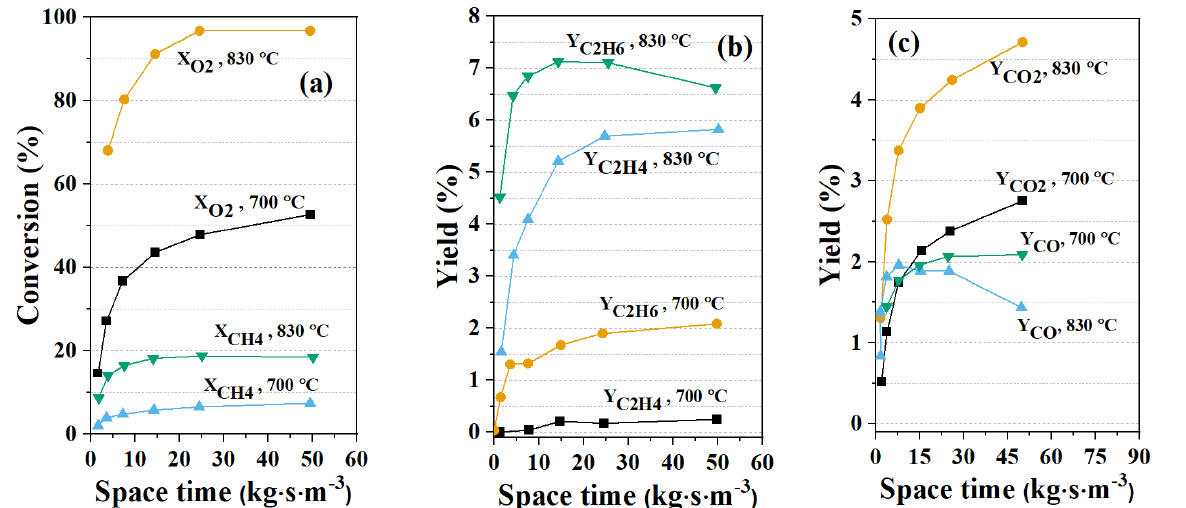
Figure 12. Effect of spatial time on ( a ) CH 4 and O 2 conversion at 700 ( ▲ , ■ ) and 830 °C ( ▼ , ● ); ( b ) C 2 H 4 and C 2 H 6 yields at 700 ( ■ , ● ) and 830 °C ( ▲ , ▼ ); and ( c ) CO 2 and CO yields at 700 ( ■ , ▼ ) and 830 °C ( ● , ▲ ). Inlet CH 4 :O 2 :N 2 feed composition equal to 70:10:20 vol% [92].